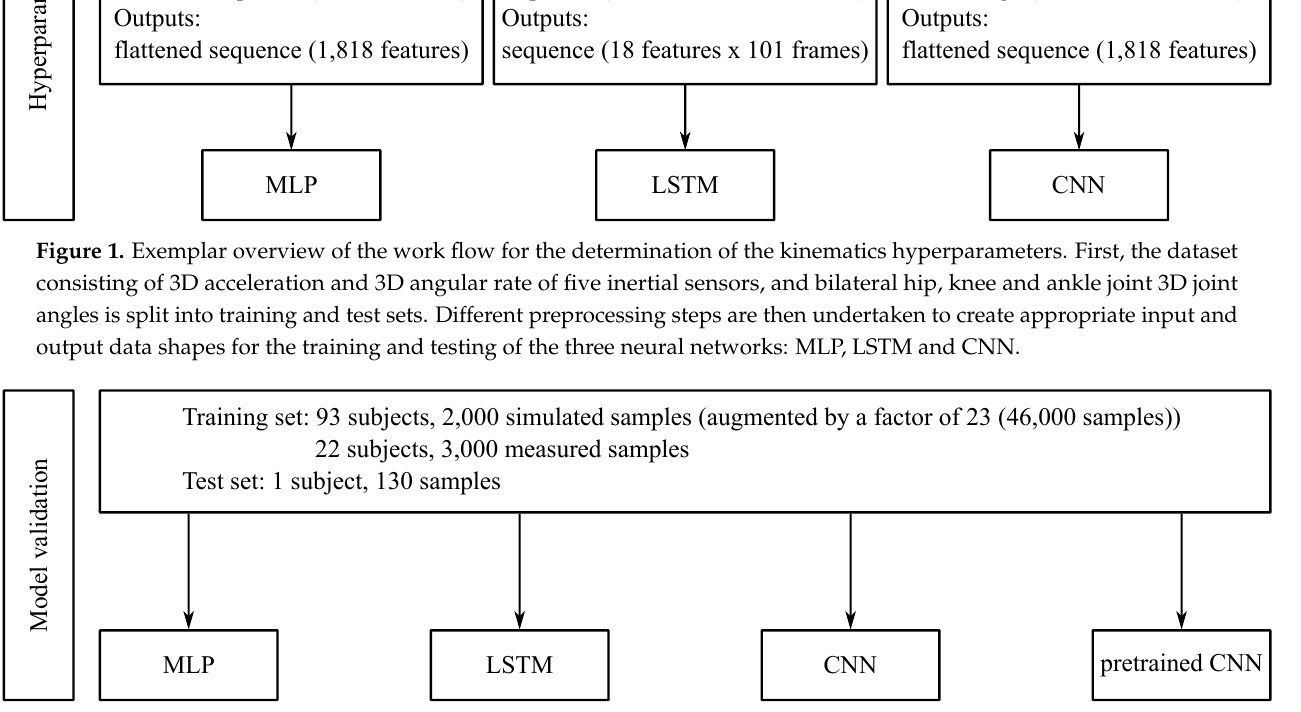
Figure 2. Overview of the work flow for the validation of the trained models. A leave-one-subject-out (LOSO) validation exemplar is displayed for the kinematics and was performed using the optimised hyperparameters for the four different models: MLP, LSTM, CNN and pretrained CNN. Based on this validation the model performance was assessed.